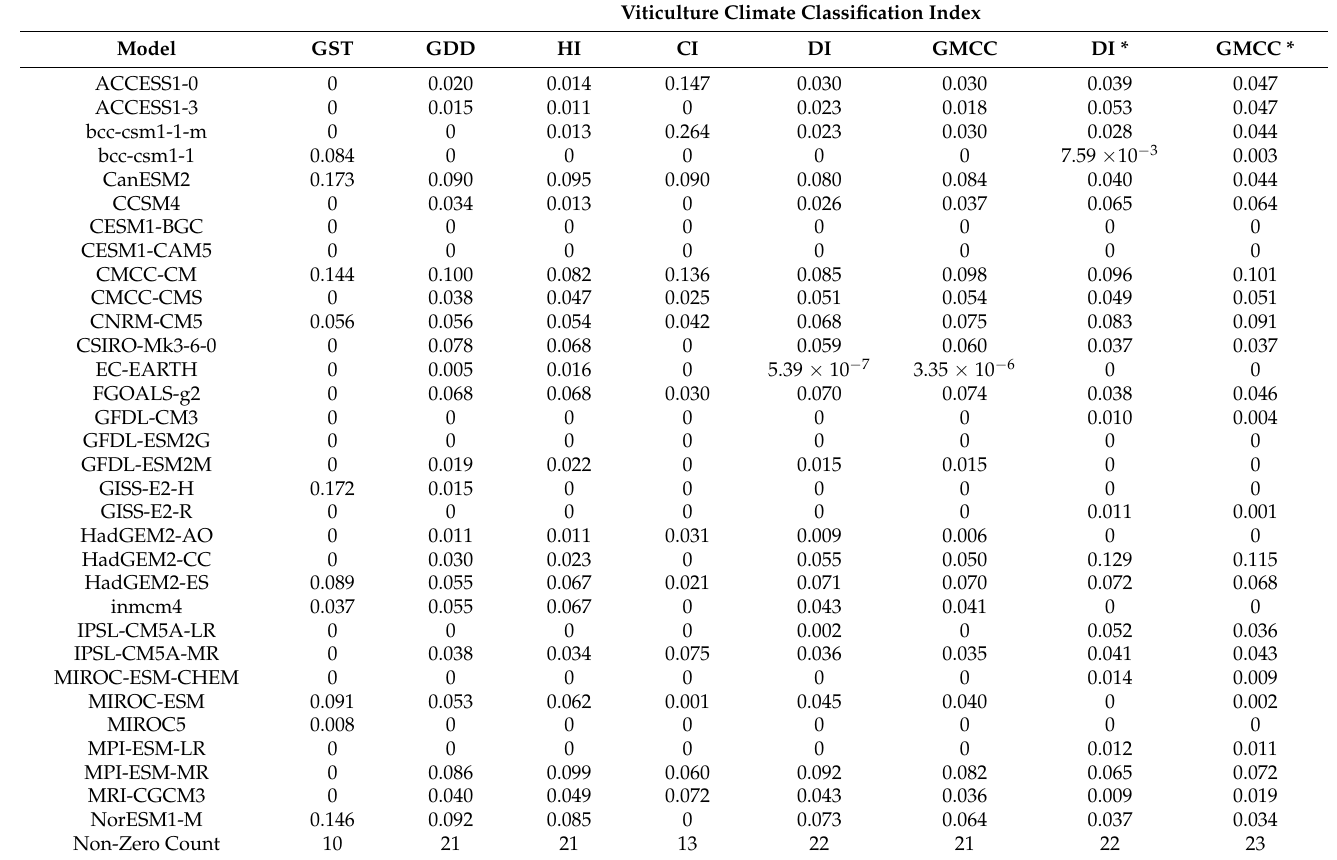
Table 5. Optimal weights obtained using elastic-net regularization [33] to assign when applying Localized Constructed Analogs (LOCA) Coupled Model Intercomparison Project phase 5 (CMIP5) historic and future climate projections [40,41] to compute the growing season average temperature (GST), growing degree days (GDD), Huglin index (HI), cool night index (CI), dryness index (DI), and the G é oviticulture multicriteria climate classification (GMCC) indices throughout the Willamette Valley American Viticultural Area (AVA). (* indicates that each functional observation group defining the index was balanced to be seen of equal importance at the start of the optimization).